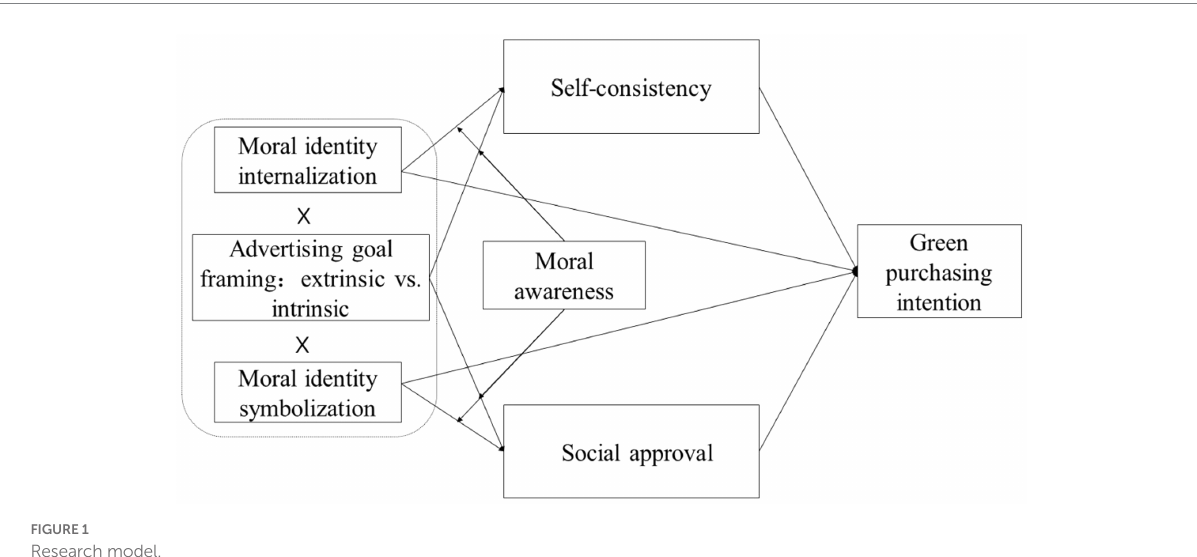
FIGURE 1 Research